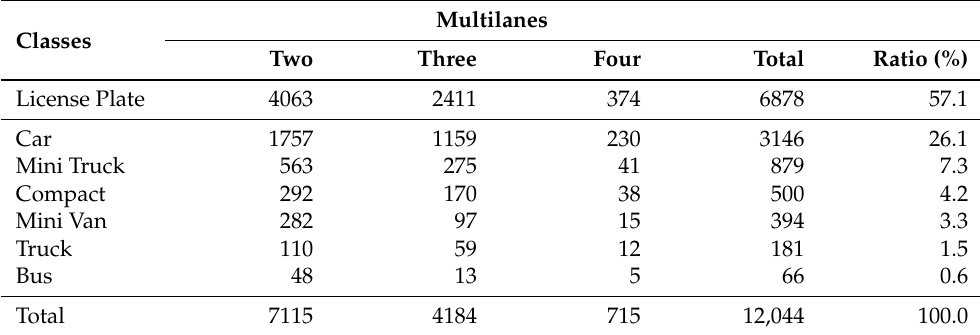
Figure 6. Classification of six vehicle types. Table 2. Our dataset of six vehicle types and LPs with corresponding distribution ratio.